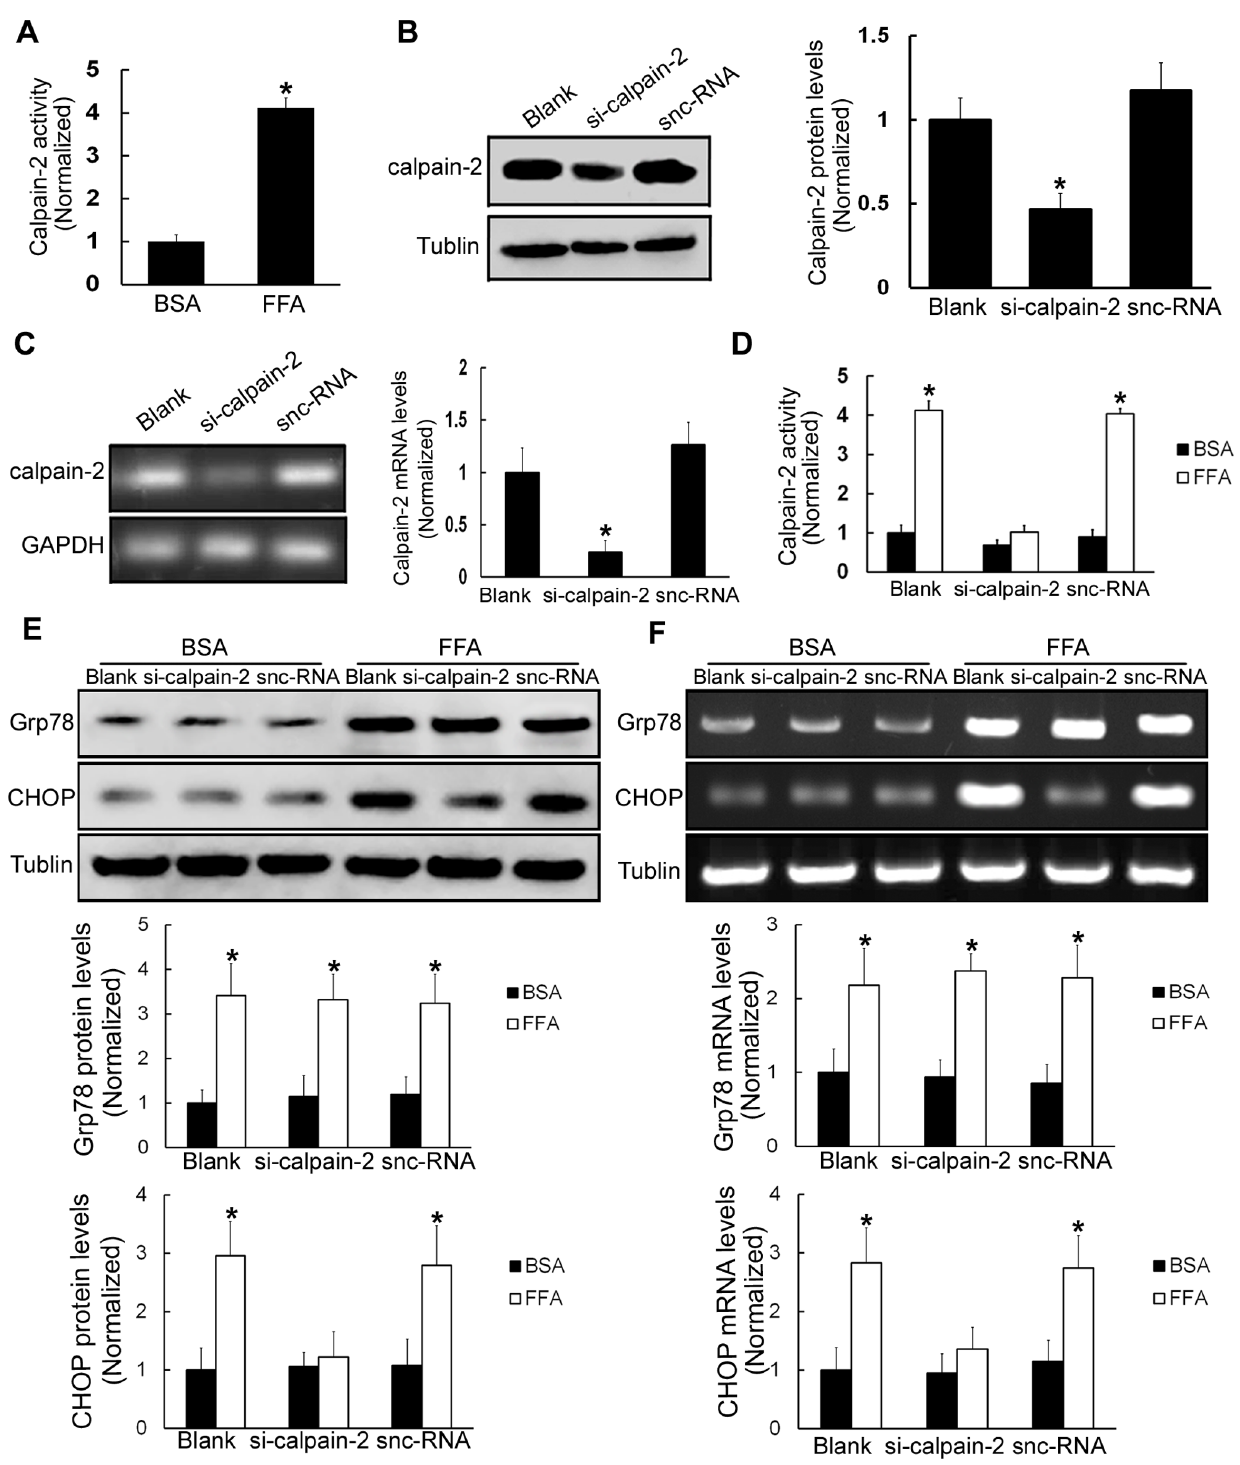
Figure 3. FFA treatments increase calpain-2 activity, thus inducing ERS in b -TC3 cells. (A) The activity of calpain-2 was tested in b -TC3 cells treated with 0.5 mM FFA or BSA for 16 h. (B) b -TC3 cells were treated with calpain-2 siRNA for 24 h. Western blot was performed to examine calpain-2 protein levels. (C) RT-PCR was used to analyze calpain-2 mRNA levels. (D) Calpain Activity Assay Kit was used to analyze calpain-2 activity. Silencer negative control siRNA (snc-RNA)-treated cells were used as a negative control. (E) b -TC3 cells were treated with calpain-2 siRNA for 24 h and then stimulated with FFA for 16 h, and western blot was used to examine the protein expression levels of Grp78 and CHOP. (F) RT-PCR was used to test Grp78 and CHOP mRNA levels. BSA-treated b -TC3 cells were used as a negative control. Bars represent each sample performed in triplicate, and the error bars represent the standard deviations. * P , 0.05, by the Student’s t -test.